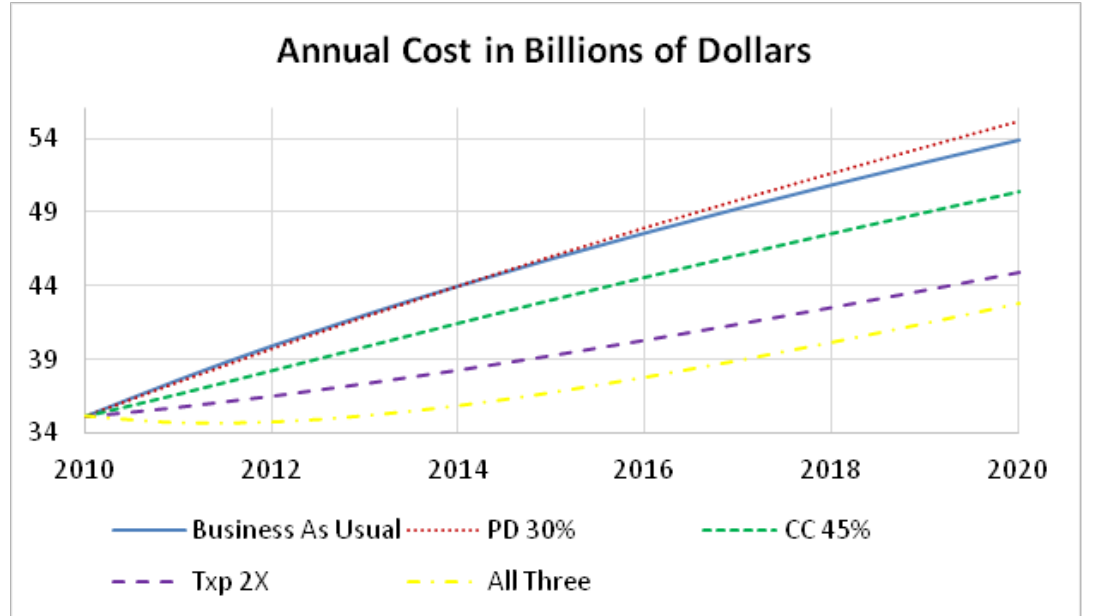
Figure 3. Source USRDS Annual Data Report 2013 and the ESRD Population